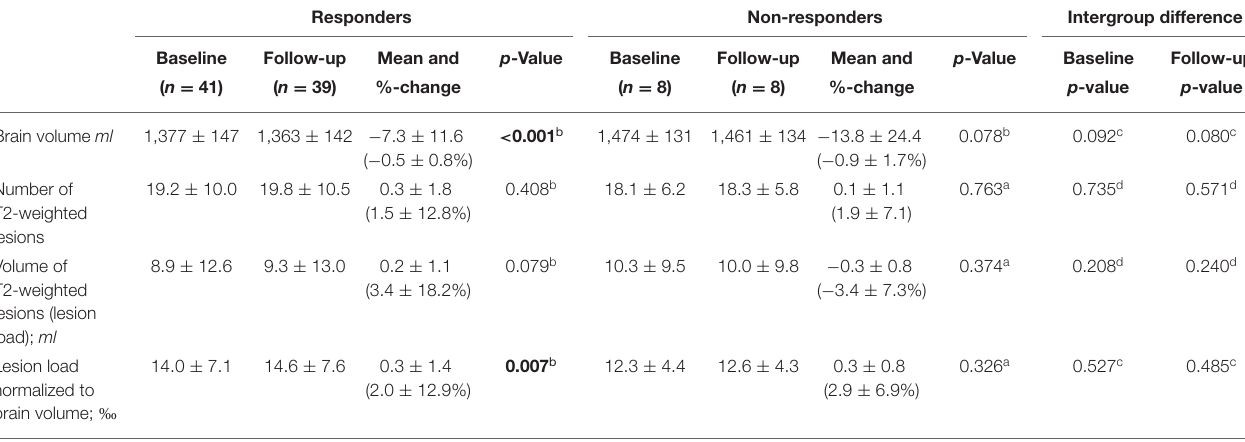
TABLE 3 | Changes in magnetic resonance imaging outcomes at baseline and after 1 year in responders and non-responders to Fampridine treatment. Responders Non-responders Intergroup difference Baseline Follow-up Mean and Baseline Follow-up Mean and p -Value Baseline